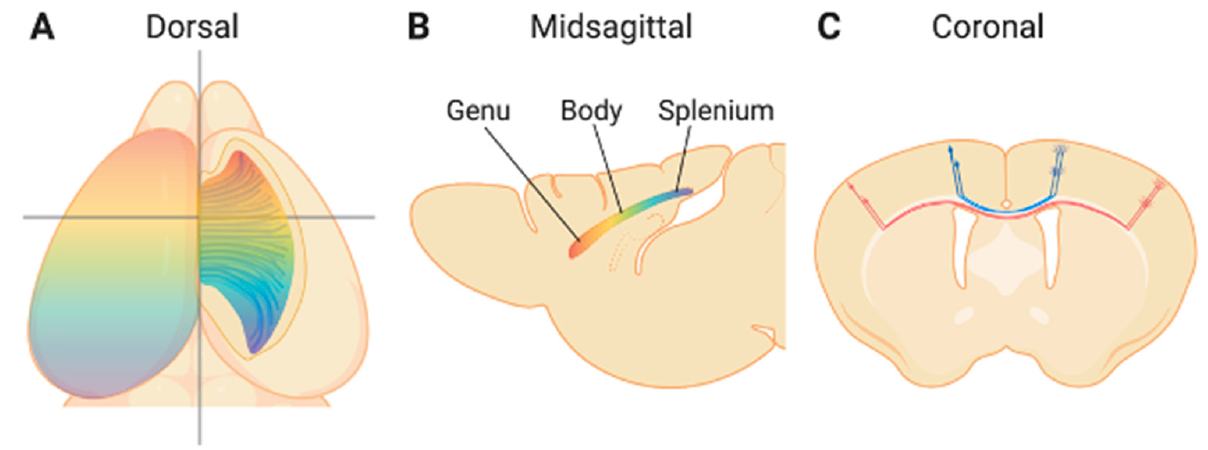
Figure 1. The organization of the mouse corpus callosum (CC). Dorsal ( A ), midsagittal ( B ), and coronal ( C ) views of the CC. Callosal axon projections from each cortical hemisphere cross the midline and primarily connect with homotopic cortical regions in a topographic manner, by which projections from anterior and posterior cortical regions form anterior and posterior parts of the CC, respectively (represented by rainbow colors in A and B ). Callosal projections from the medial and lateral regions of the cortex form the dorsal and ventral portions of the CC, respectively ( C ).